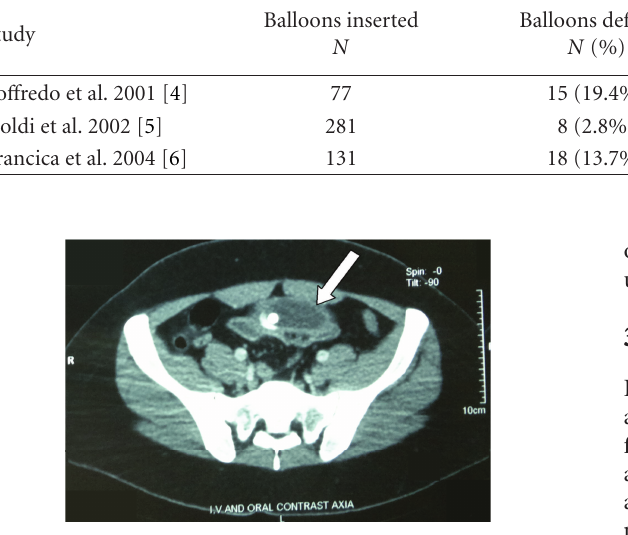
Figure 1: Abdominal CT scan showing the deflated intragastric balloon migrated to the small bowel (white